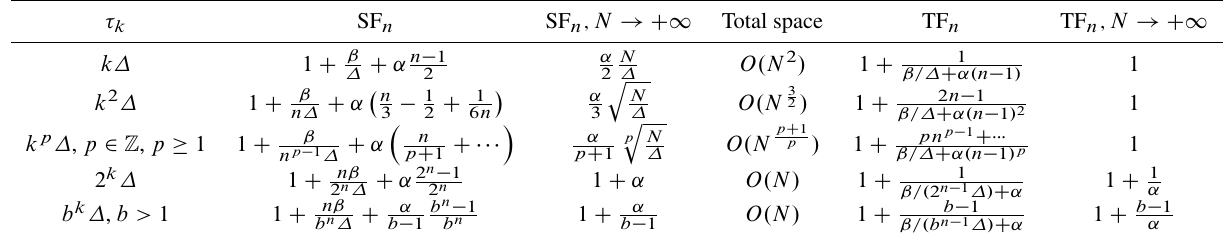
Table 1 Space and time factors of different time split policies. N = (cid:28)(cid:28)(cid:28) n stands for total number of events. (cid:1)(cid:1)(cid:1) is a constant controlling the time split